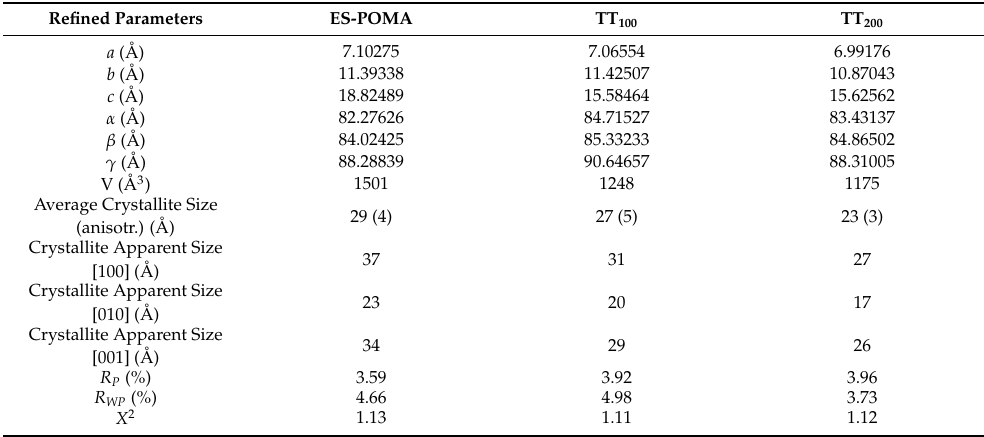
Table 1. Le Bail method performed for ES-POMA, TT 100 , and TT 200 using the program Fullprof: cell parameters, average size, and anisotropy, crystallite apparent size and agreement factors.